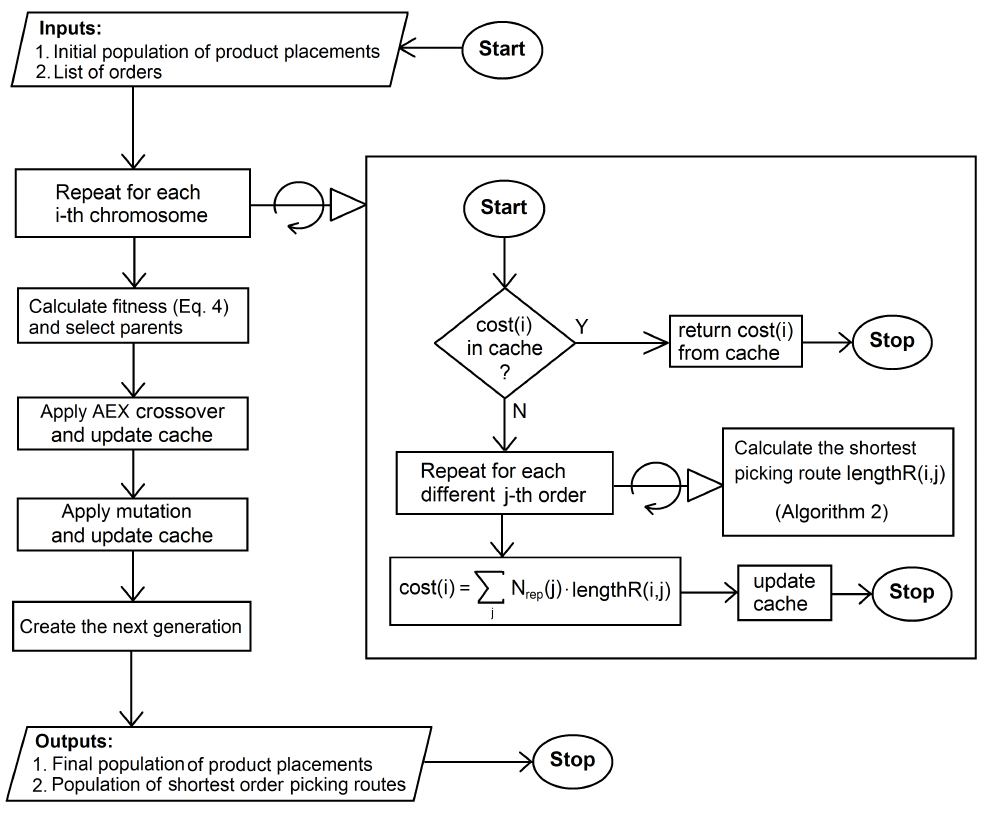
Figure 3. Product Placement Optimization (inner block of the algorithm shown in Figure